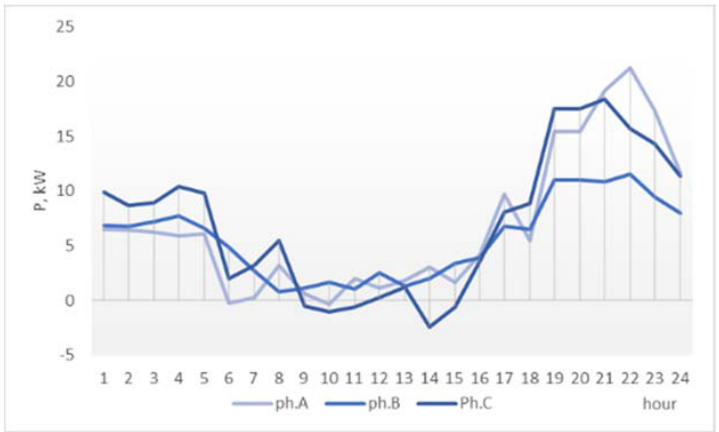
Figure 12. Actual bus demand in network R28 (aggregated demand and generation)—three-phase PSM.